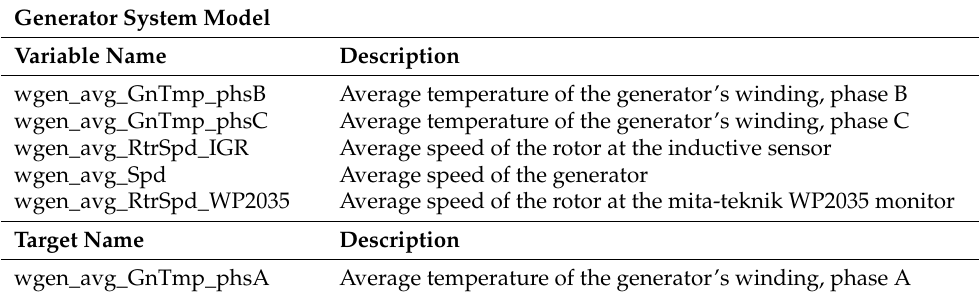
Table 1. Summary of the variables and target used for the generator